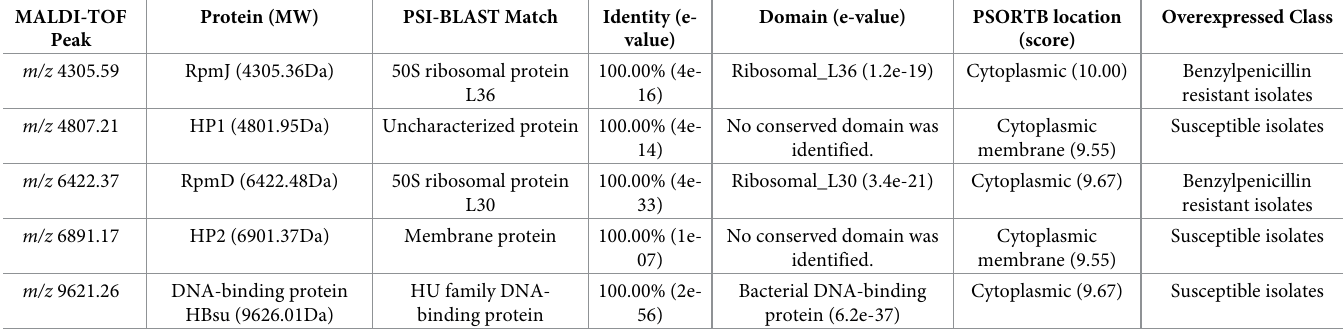
Table 3. Annotation of the S . aureus proteins corresponding to the five MALDI-TOF peaks recognized as significant by the trained classifiers: peak mass charge ratio, predictedprotein mass, top PSI-BLAST matches, conserved domain analyses, cellular locations and overexpressed classes are shown. MALDI-TOF Peak